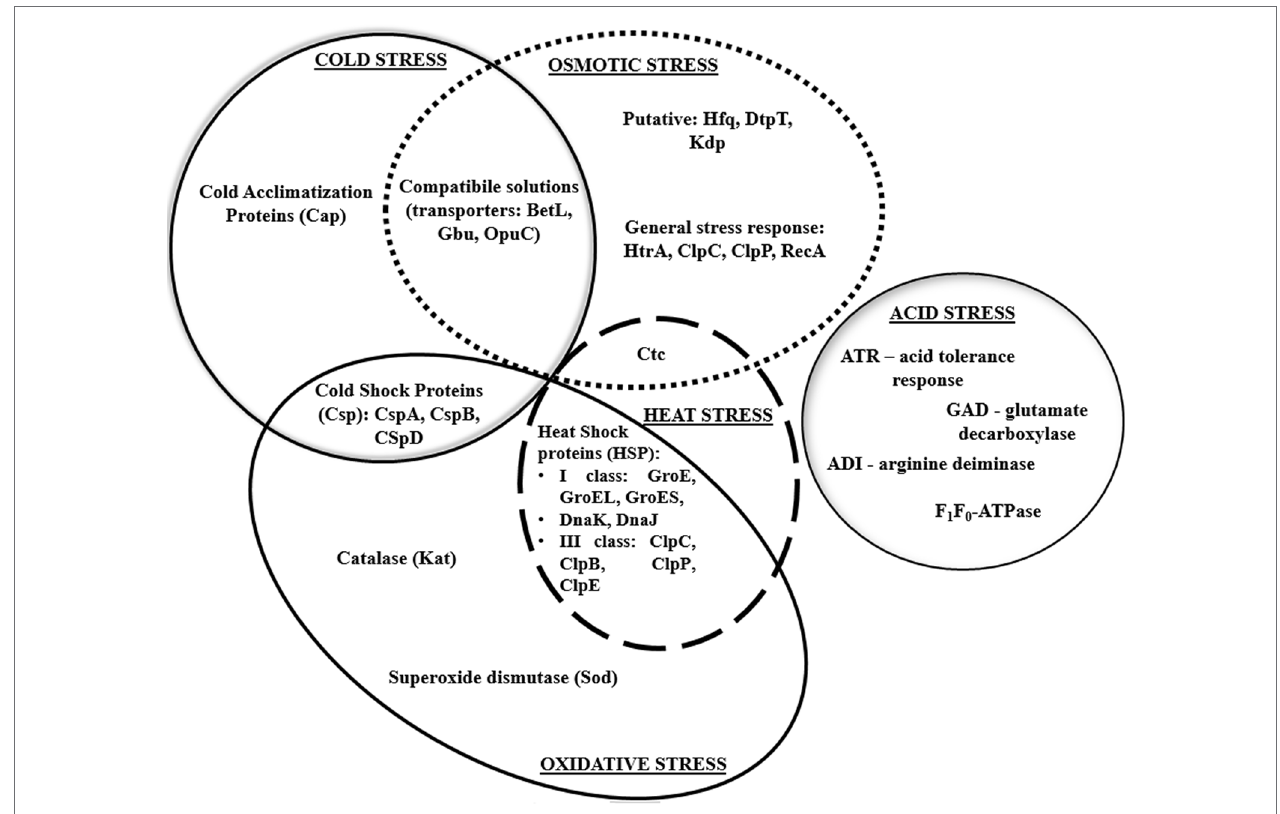
FIGURE 5 | Interaction of various stress response mechanisms in L. monocytogenes